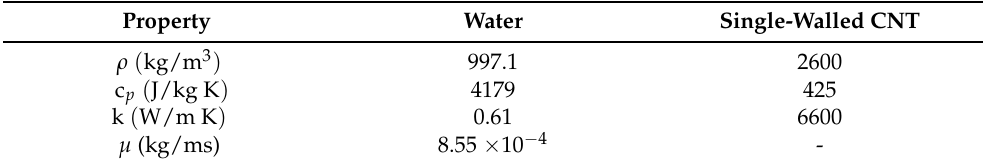
Table 2. Base fluid and nanoparticle properties.